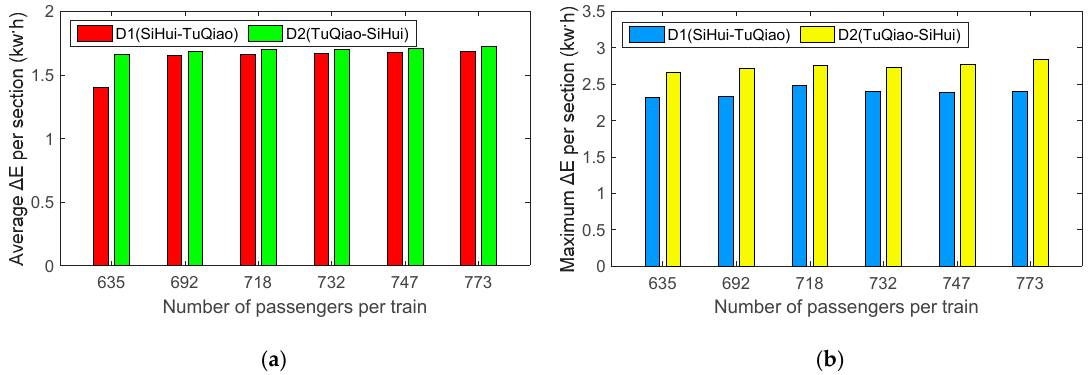
Figure 14. Statistical results of average energy reduction per section from the weekday timetable. ( a ) Comparison of average results; ( b ) Comparison of maximum results.